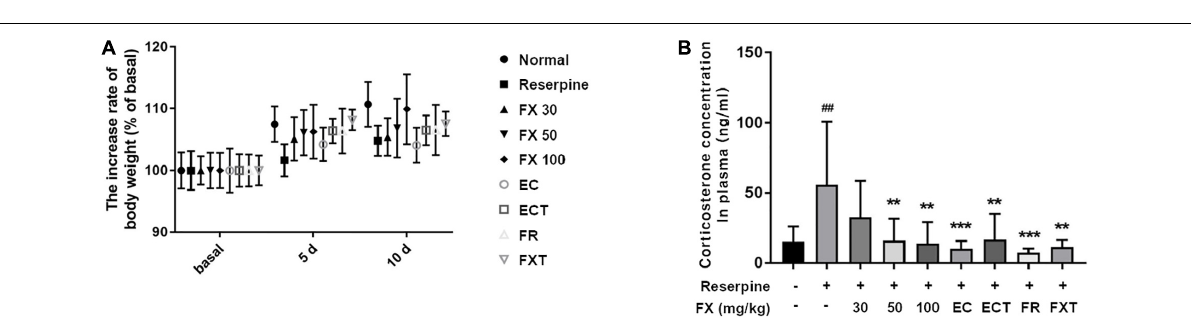
and the number of pCREB positive neurons in the hippocampus (32.43 ± 9.27, p < 0.0001). However, FX 100, ECT, and FR-treated groups significantly restored the expression of pCREB (FX 100: 72.7 ± 15.41, p = 0.0024; ECT: 63.67 ± 23.84, p = 0.0395; and FR: 64.82 ± 16.95, p = 0.0279; Figure 7B ) and the number of pCREB positive neurons (FX 100: 116.3 ± 32.05, p = 0.0231; ECT: 174.4 ± 94.02, p < 0.0001; and FR: 116.6 ± 50.16, p = 0.0359; Figure 7C ). Reserpine administration also reduced